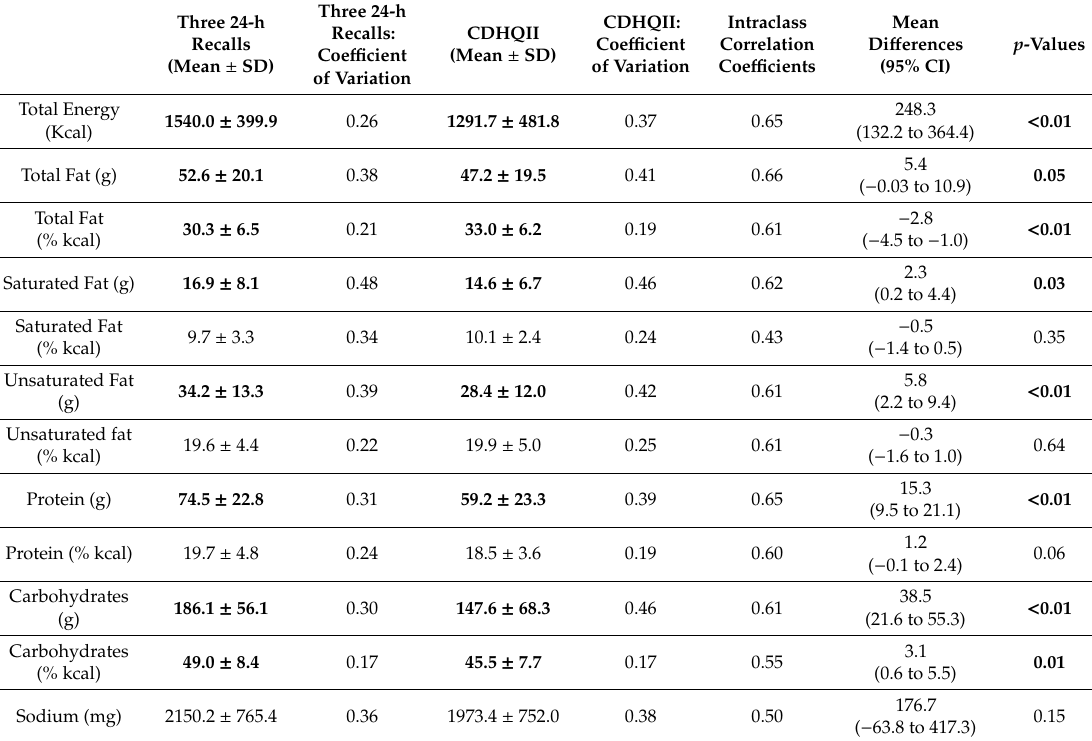
Table 2. Comparison of three 24-h recalls and CDHQII at 3-month follow-up.